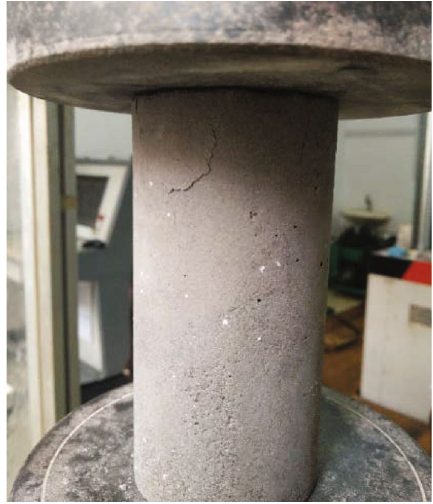
Figure 4: Uniaxial compressive strength